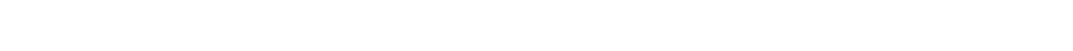
FIGURE 1 |The 16 different types of problems used in the experiments .The upper eight are 45˚ problems and the lower eight are 90˚